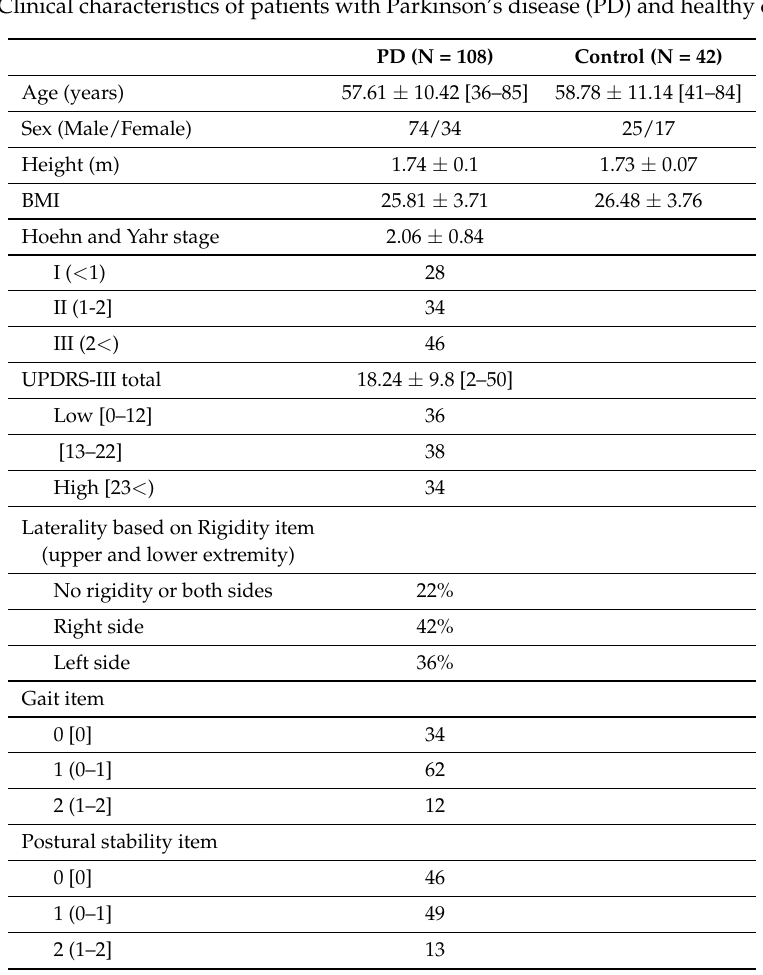
Figure 1. ( a ) Shimmer sensor placement and axes definition. ( b ) Definition of turning angle, stride length, path length, and swing width. Table 1. Clinical characteristics of patients with Parkinson’s disease (PD) and healthy